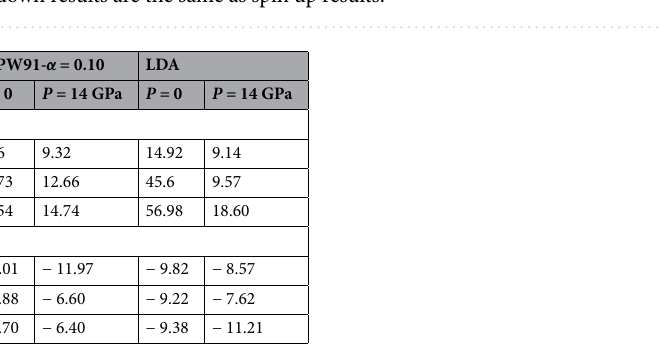
Figure 1. ( ai1 ) Maximum positive or hole-like of spin up Seebeck coefficient ( S max − pos ) and ( bi1 ) maximum negative or electron-like of spin up Seebeck coefficient ( S max − neg ) of hole/electron doped CeIn 3 versus temperature calculated by B3PW91 with α = 0.20, 0.10 and LDA for P = 0 and 14 GPa pressures. Doping levels related to S max − pos and S max − neg are displayed in the ( ai2 ) and ( bi2 ) panels, respectively. The i-index varies from 1 to 3. In the AFM phase, spin down results are the same as spin up results.